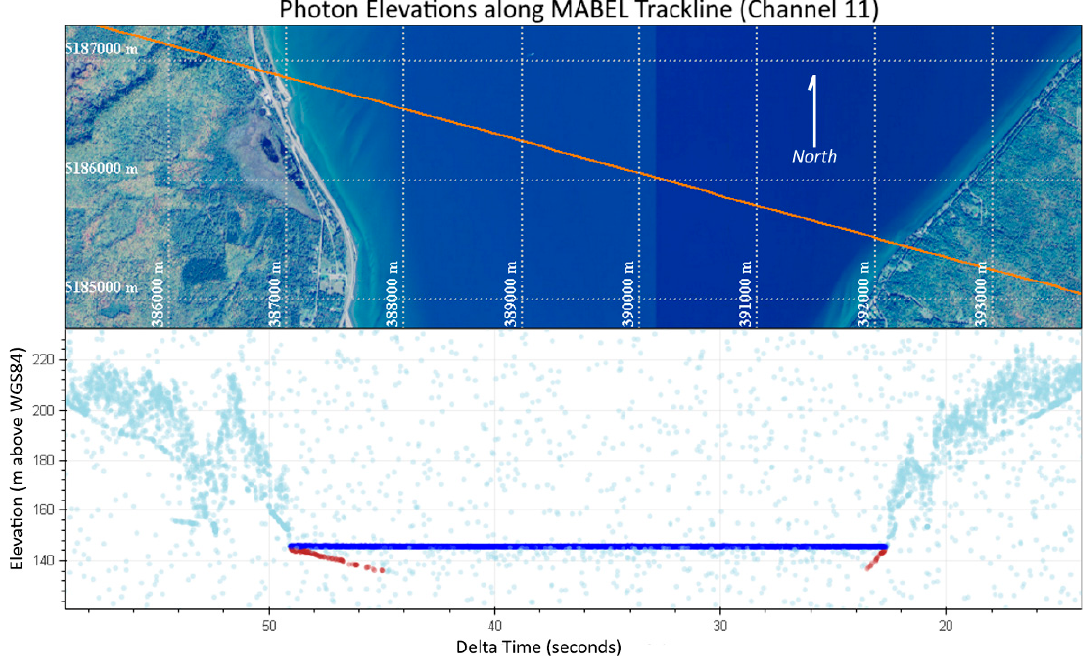
Figure 4. Characteristic water-surface and bottom profiles are clearly discernable in the MABEL data. The delta time on the x-axis is shown in reverse order so that the spatial orientation of the photon elevation data coincides with the 1-m resolution National Agriculture Imagery Program (NAIP) imagery shown above (i.e., viewing the track left-to-right in the above image). In addition to the surface and bathymetric returns, ground and vegetation returns are also discernable in the MABEL photon elevation data. The overlain grid shows World Geodetic System 1984 (WGS84), Universal Transverse Mercator (UTM) zone 16N coordinates.